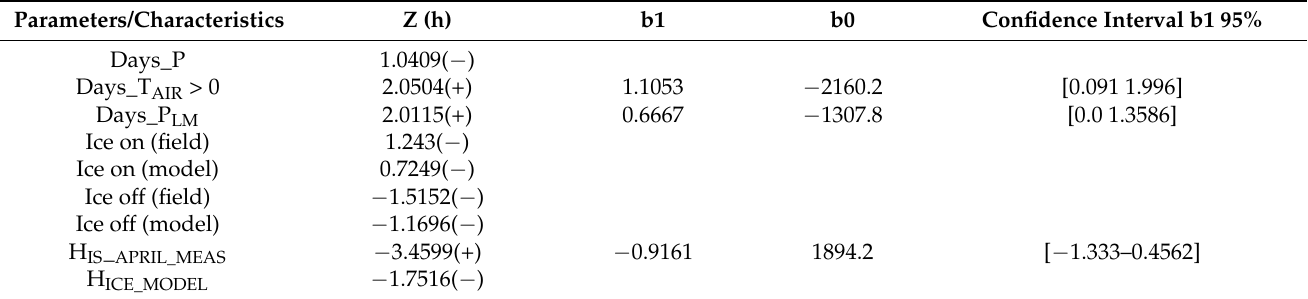
Table 1. Estimates of the statistical significance of trends (1994–2020) by Mann–Kendall test (minus means the trend is not significant, plus means the trend is significant at the level less than